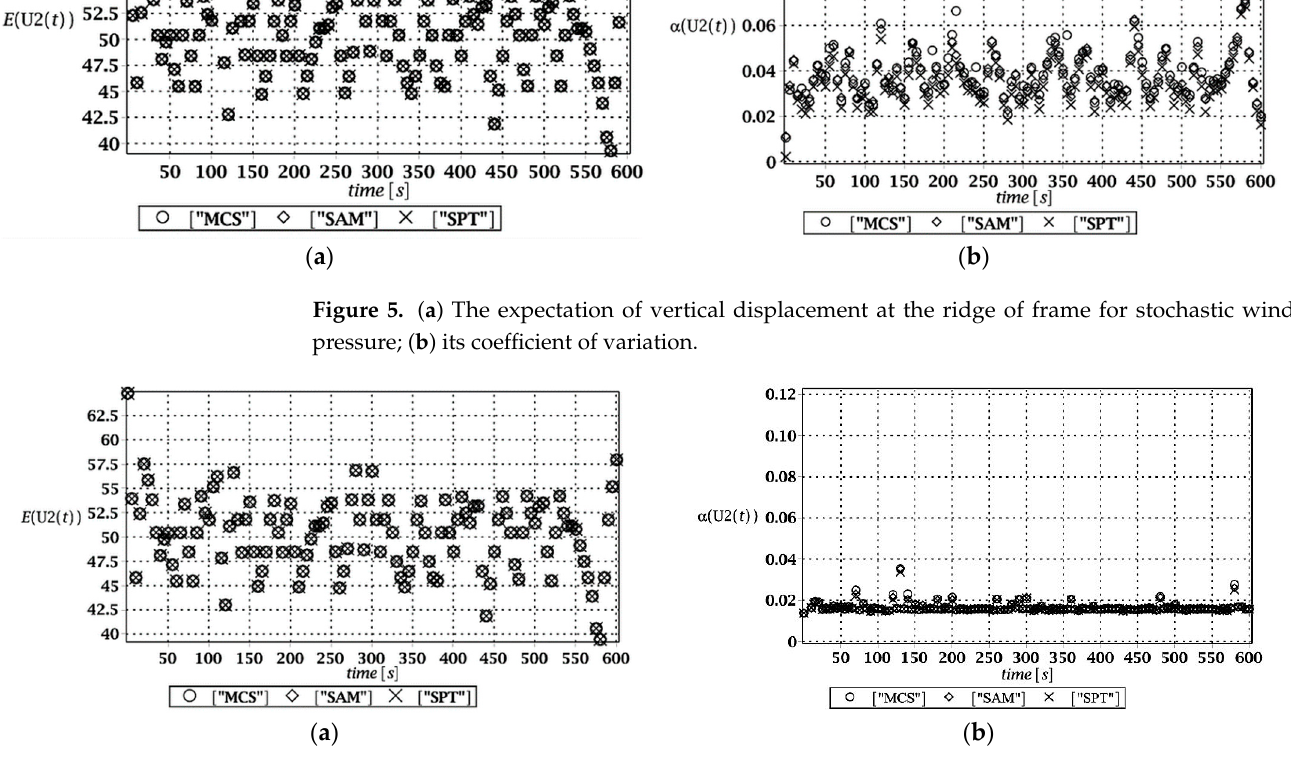
Figure 6. ( a ) The expectation of vertical displacement at the ridge of frame for uncertain Young’s modulus; ( b ) its coefficient of variation.